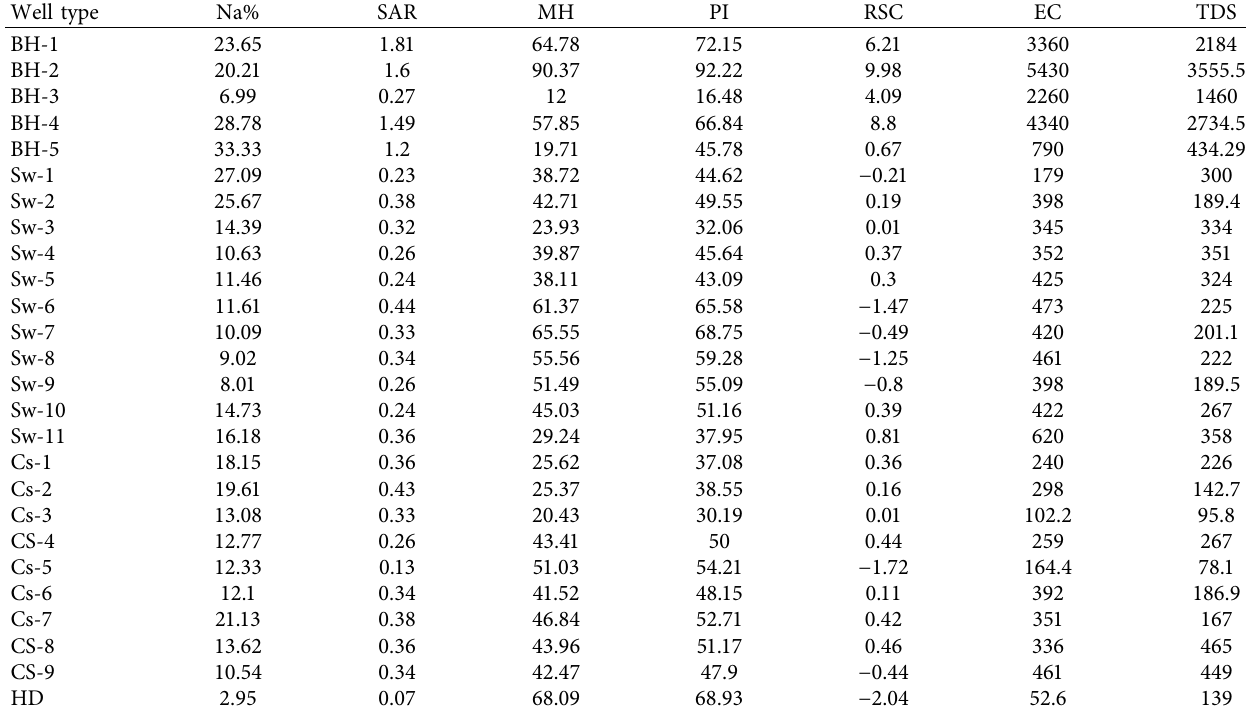
Table 7: Computed values of Na%, SAR, MH, PI, RSC, EC, and TDS for irrigation water quality. Well